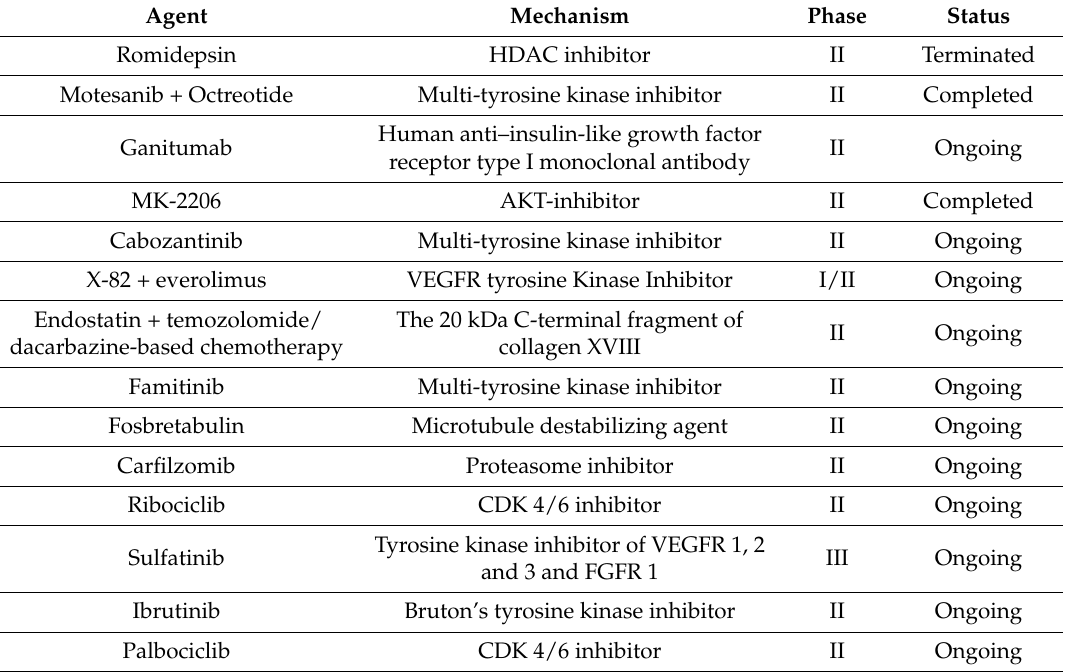
Table 4. Clinical trials using new agents for